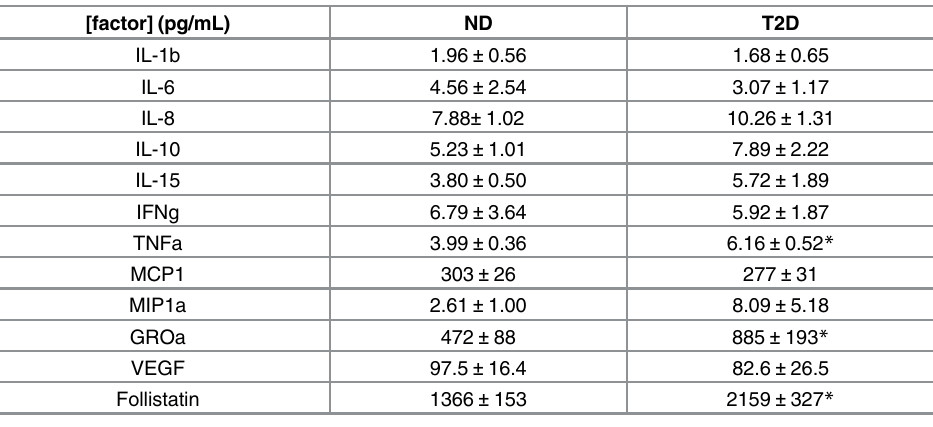
Table 2. Circulating cyto- and chemokine